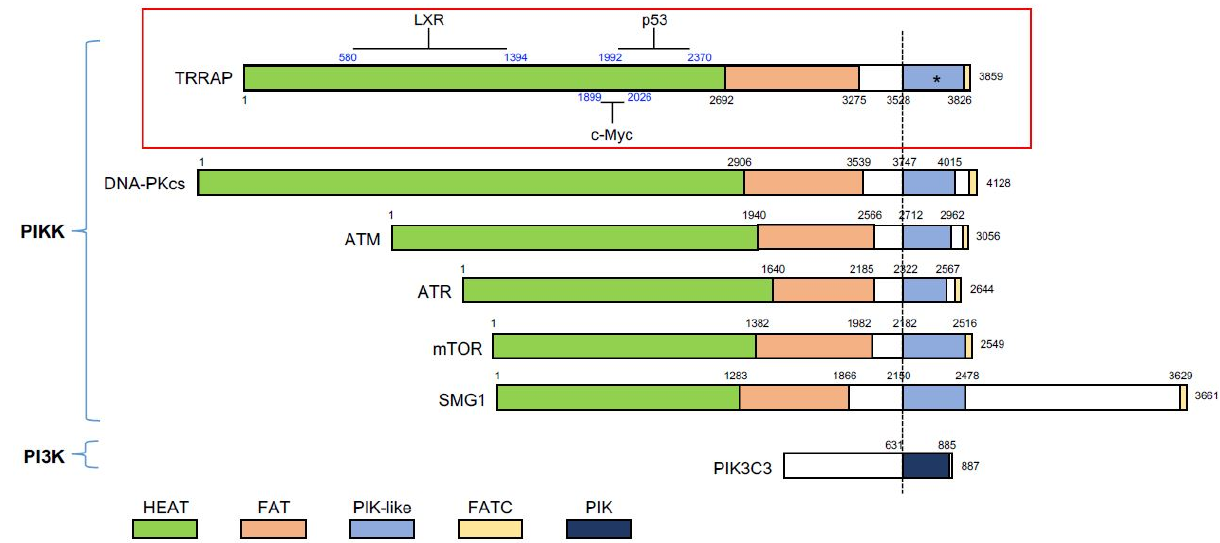
Figure 1. Protein domains of the phosphatidylinositol 3-kinase-related kinase (PIKK) family members. All members contain the PIK-like domain that confers kinase activity, except TRRAP that lacks the key motifs (marked with asterisk). The PIK-like domain is flanked by the FAT domain and the FATC domain. PIK3C3, a member of phosphoinositide 3-kinases (PI3K), serves as a comparison. The known regions (blue numbers) in TRRAP, which interact with p53, c-Myc, and LXR (liver X receptor), are shown. Many of the proteins have been reported to associate with TRRAP; however, if there are no exact regions mapped, these proteins are not shown. The black numbers indicate the amino acid sequence of TRRAP. All of the proteins were aligned with the dashed line, which indicates the N-terminal border of the PIK-like/PIK domain. PIKK, phosphatidylinositol 3-kinase-related kinase; PI3K, phosphoinositide 3-kinases; PIK3C3, phosphatidylinositol 3-kinase catalytic subunit type 3.